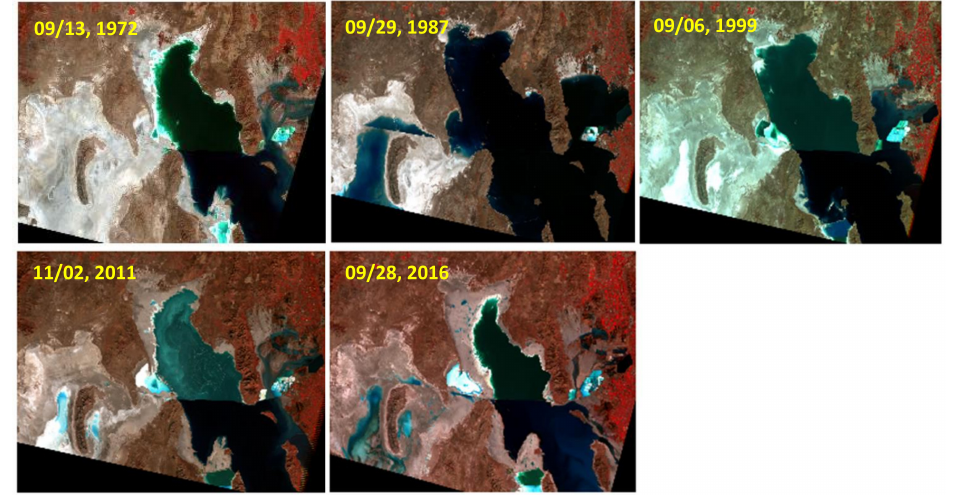
Figure 1. Landsat images (1972, 1987, 1999, 2011, and 2016) displayed in false color for the Great Salt Lake (GSL) and the GSL desert that is on the left side of the lake in the imagery. Sources and more details are available at http://Earthshots.usgs.gov, Earthshots: Great Salt